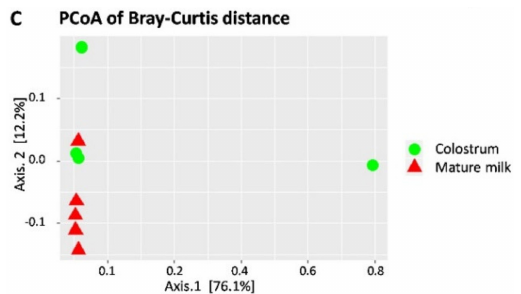
Figure 2. The beta diversity (between microbial diversity) of the colostrum and milk microbiota from three farms, based on principal coordinate analysis (PCoA) plots using the Bray–Curtis distances. Each point on the PCoA plots represents the microbial community from a single sample. Samples with the most similar microbial communities cluster together. The first coordinate (Axis 1) explained 54.8% ( A ), 29.2% ( B ), and 76.1% ( C ) and the second coordinate (Axis 2) explained 26.2% ( A ), 22.2% ( B ), and 12.2% ( C ) of the variation between colostrum and mature milk samples. Colostrum clusters very closely with no discernible di ff erence in farm A and farm B. However, mature milk clusters are long distances from each other (the colostrum and mature milk did not statistically di ff er).